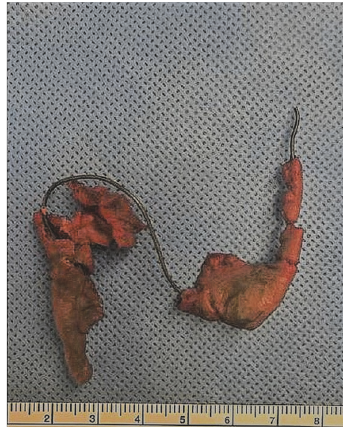
Figure 1: Chest X-ray showing a curvilinear metallic object overly- ing the upper mediastinum.